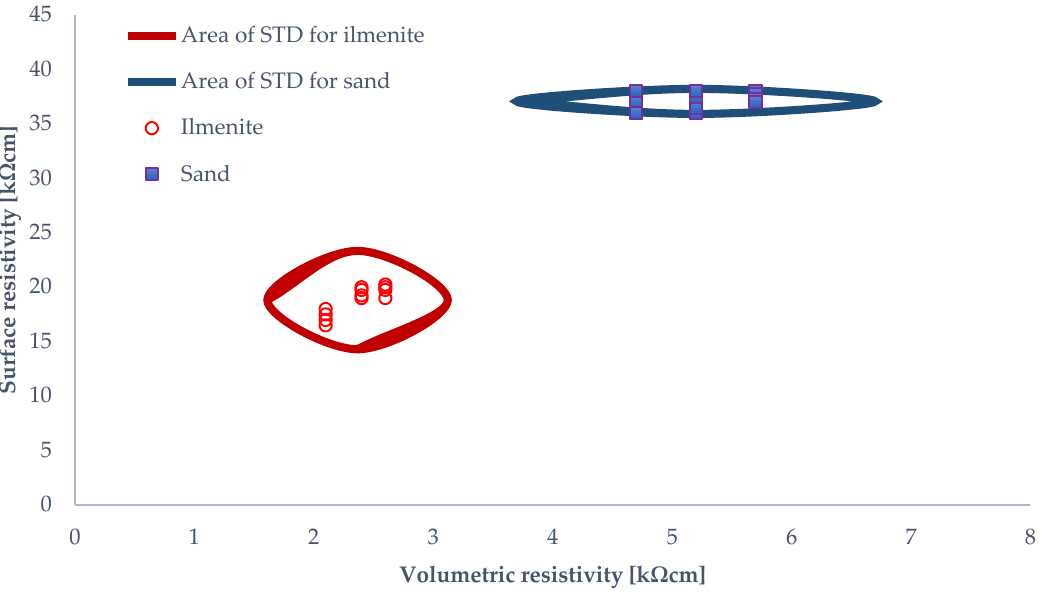
Figure 6. Correlation between the values of surface resistivity and volumetric resistivity. Other results are the correlations of bulk resistivity and compressive strength in Figure 7. The measured data are in the deviation edge area.